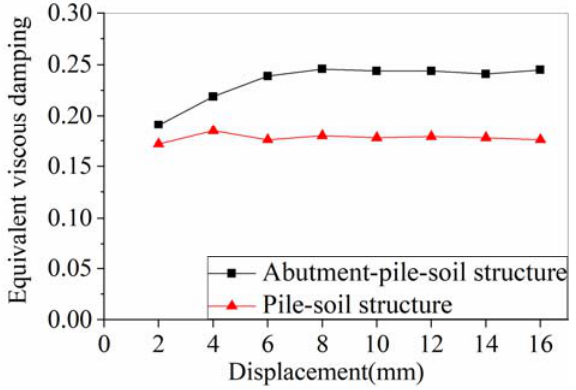
Figure 16. Equivalent viscous damping.